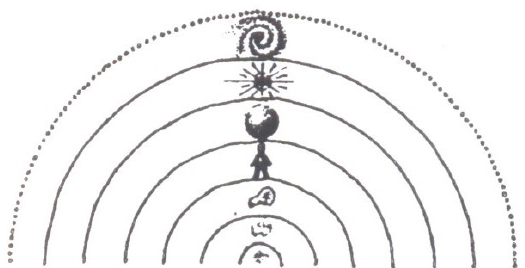
Figure 1. My Appearance for Others from Different Distances: Galaxy, Star, Planet, Human, Cells, Molecules, Atoms, etc. (Harding 2001, p. 31). Reproduced with Permission from the Shollond Trust.